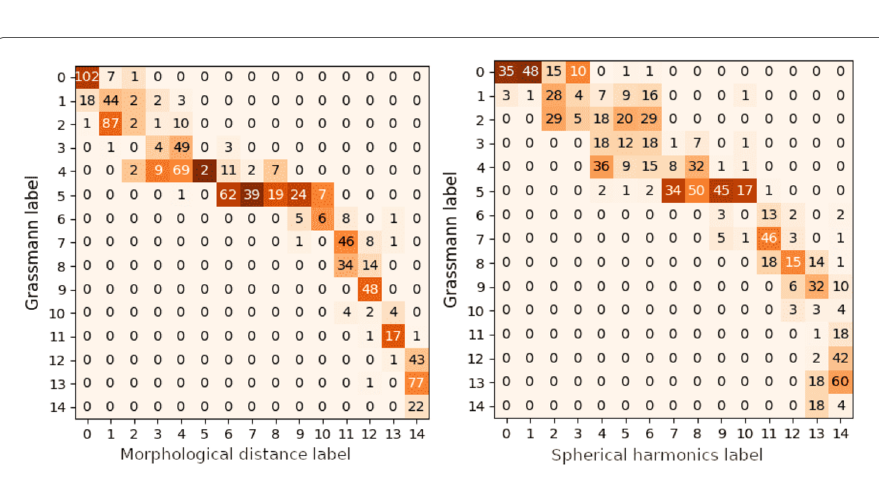
Figure 9 Confusion matrix showing the number of shapes in Grassmann-based clusters with respect to clusters based on the morphological distance (left) and the spherical harmonics distance (right)